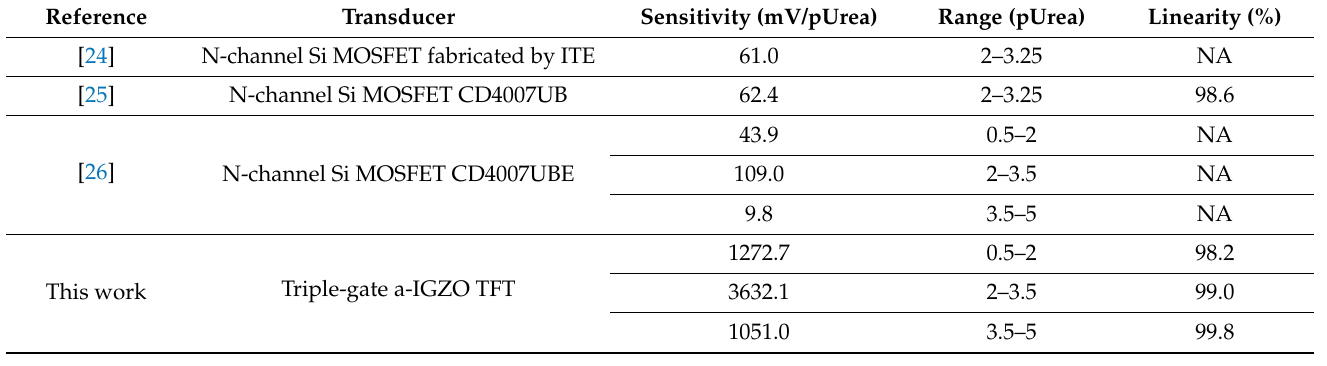
Table 4. Comparison of the analysis characteristics of the proposed urea-EnFET sensor platform and previously reported